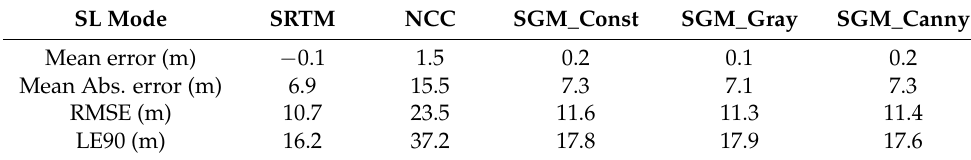
Table 6. Height accuracy of DSM generated from Spotlight stereo pair in test area 2.